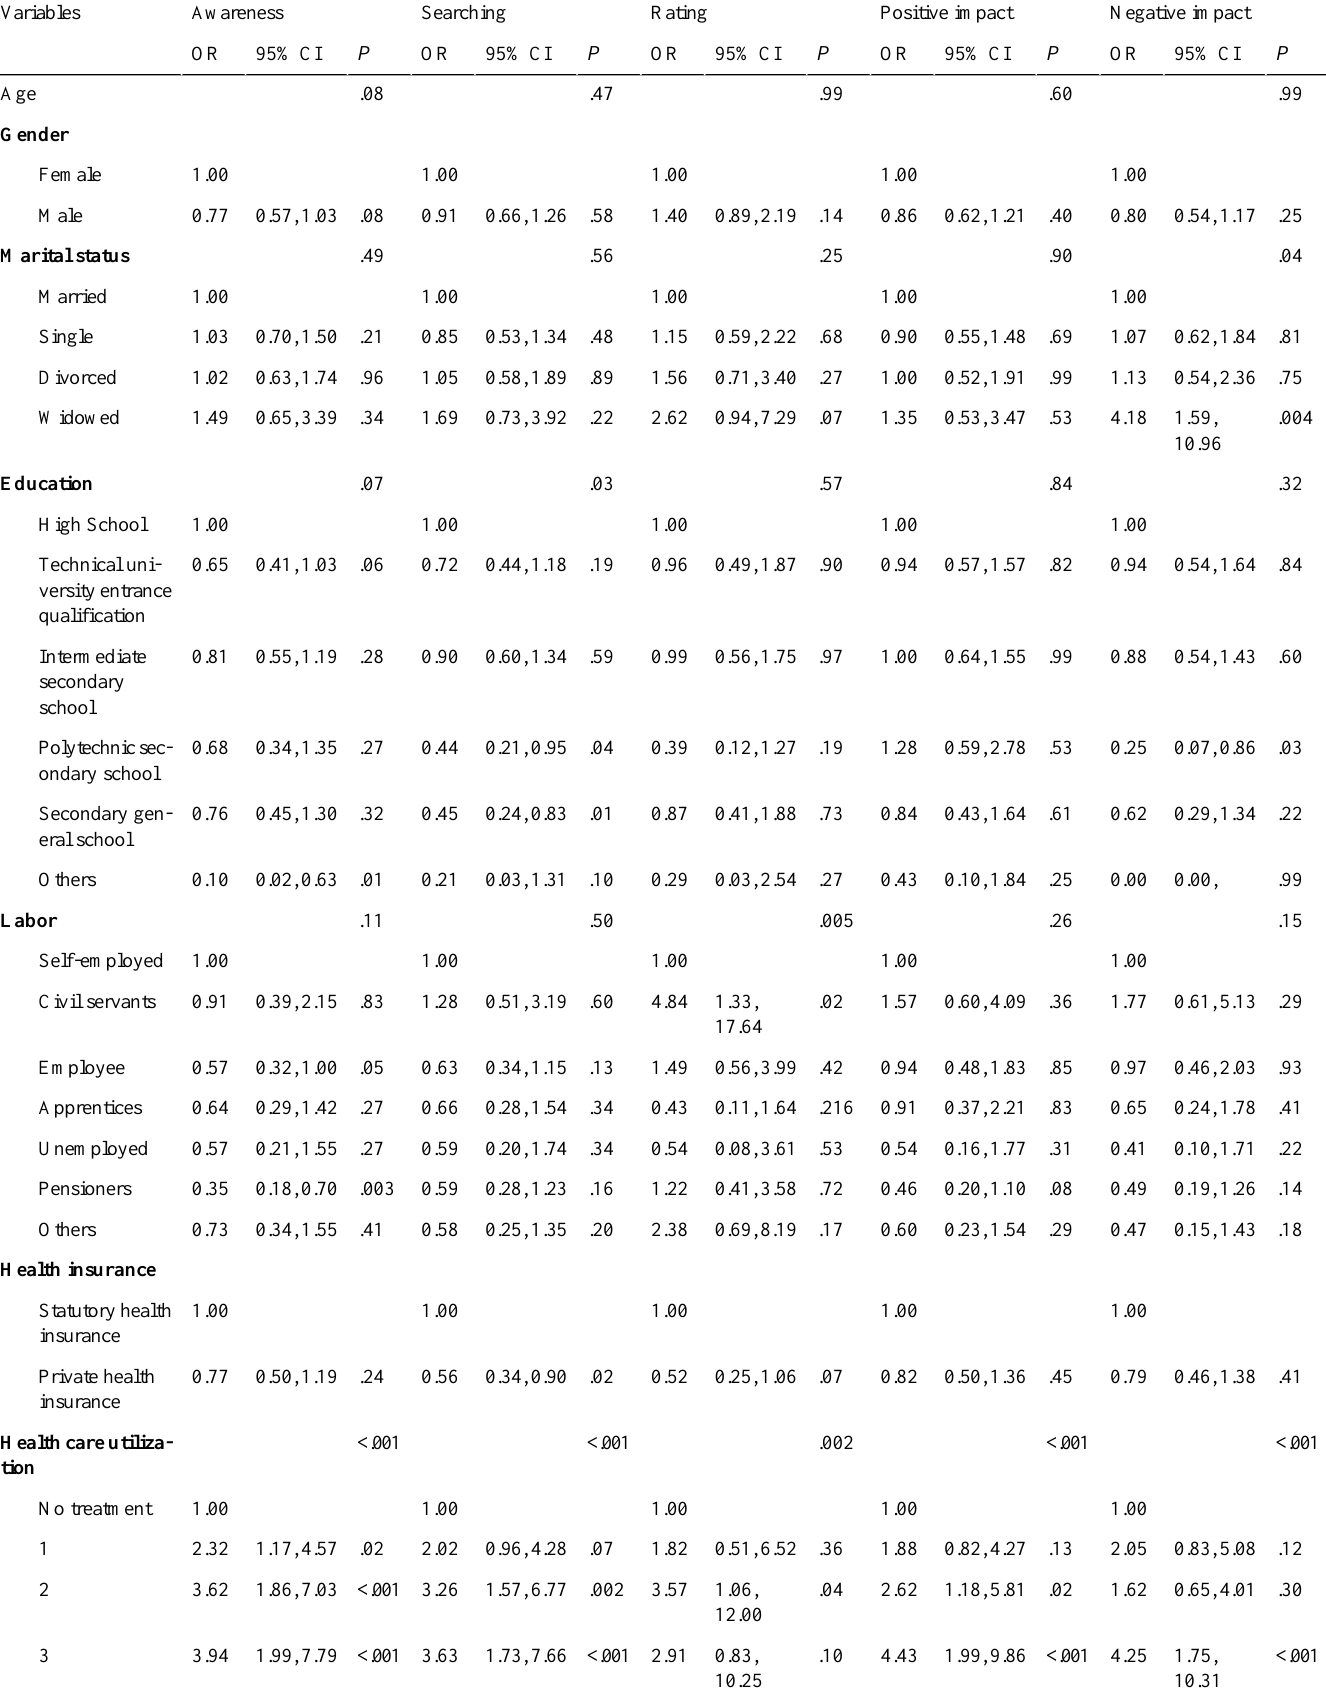
Table 5. Independent factors associated with physician-rating website relevant topics (weighted sample).